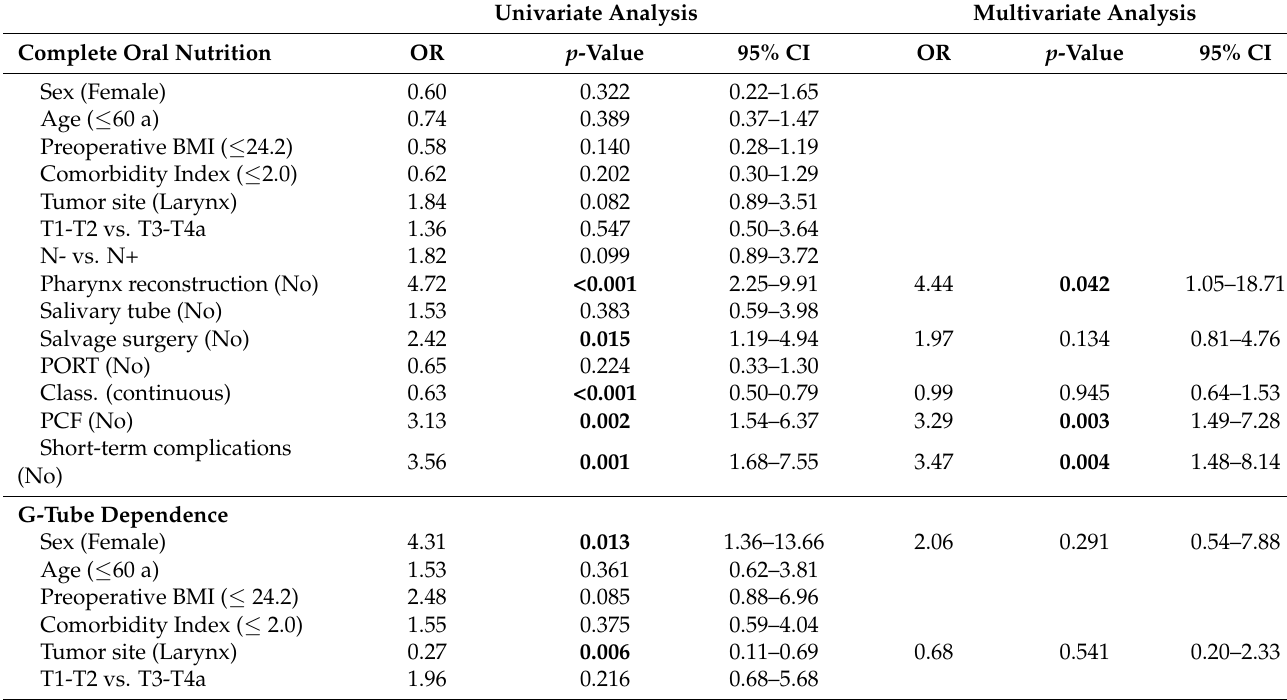
Table 4. Complete oral nutrition, G-tube dependence, and pharyngeal stenosis. Univariate Analysis Multivariate